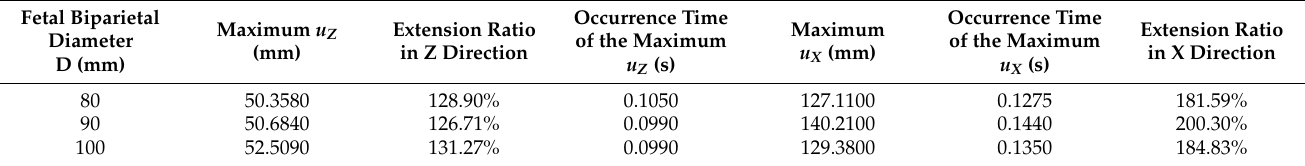
Table 6. Maximum